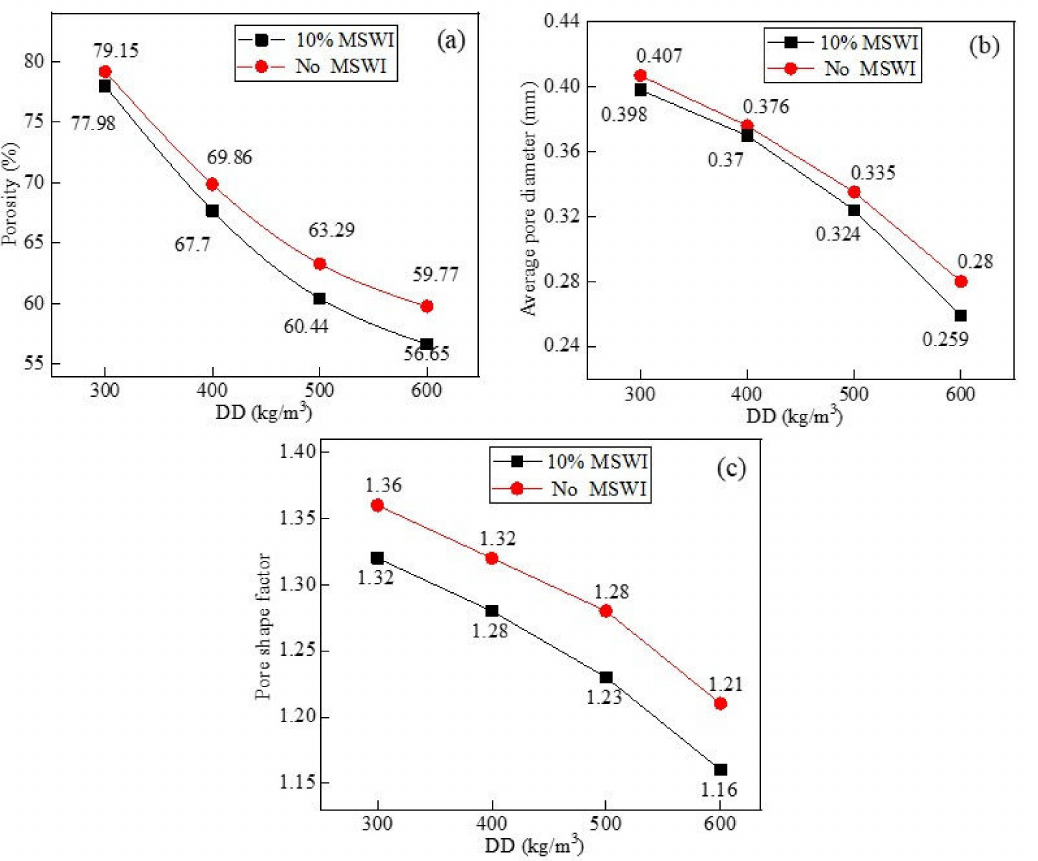
Figure 11. Porosity ( a ), average pore diameter ( b ), and pore shape factor ( c ) of the recycled foamed concrete containing MSWI powder with different dry